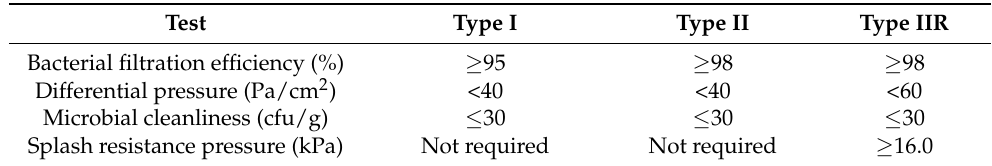
Table 1. Performance and requirements of medical face masks as per international standard EN